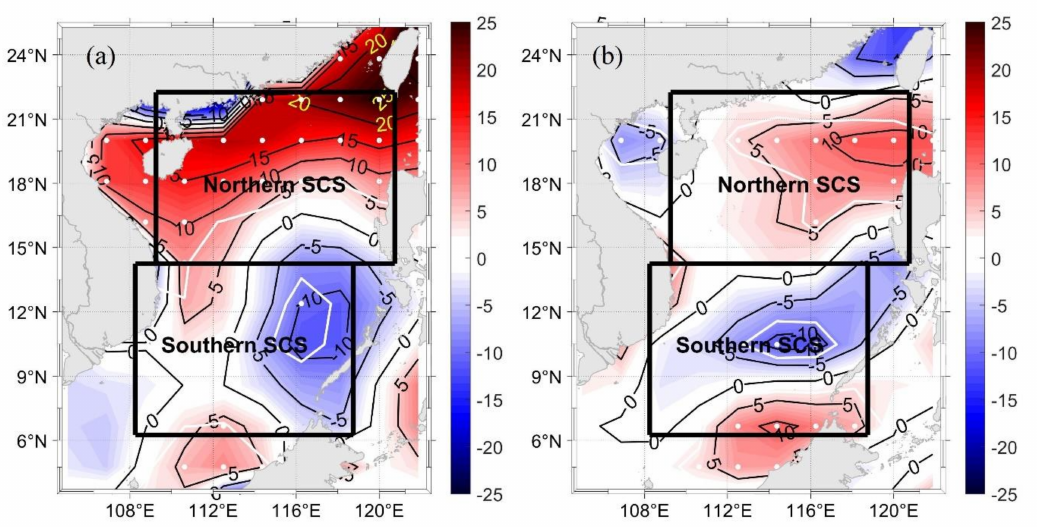
Figure 7. As in Figure 6 during mature winters of ( a ) EP El Niño and ( b ) CP El Niño events, but for latent heat flux